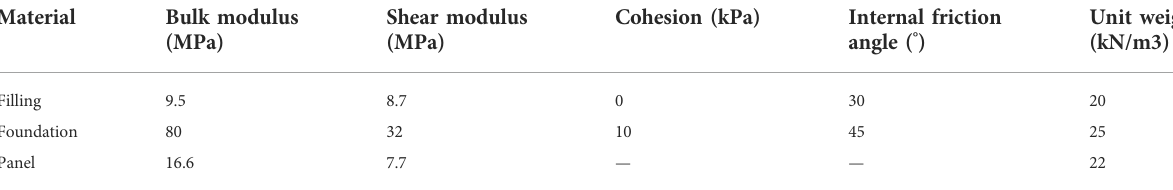
TABLE 1 Material properties of the numerical model.